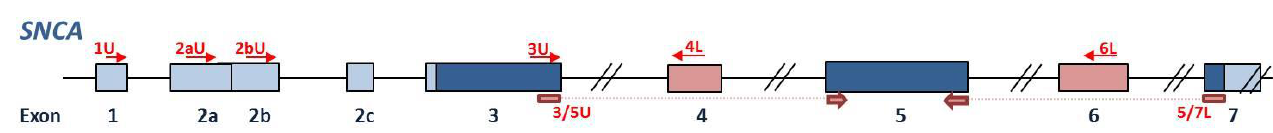
results; * these primers comprise transcript-specific sequences.